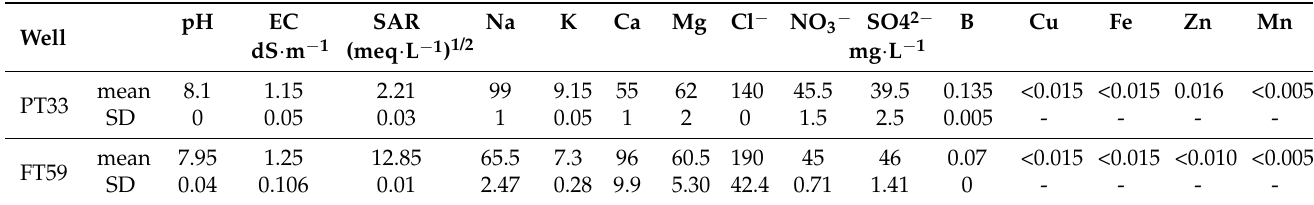
Table 3. Chemical parameters analyzed of groundwater, CW, from two